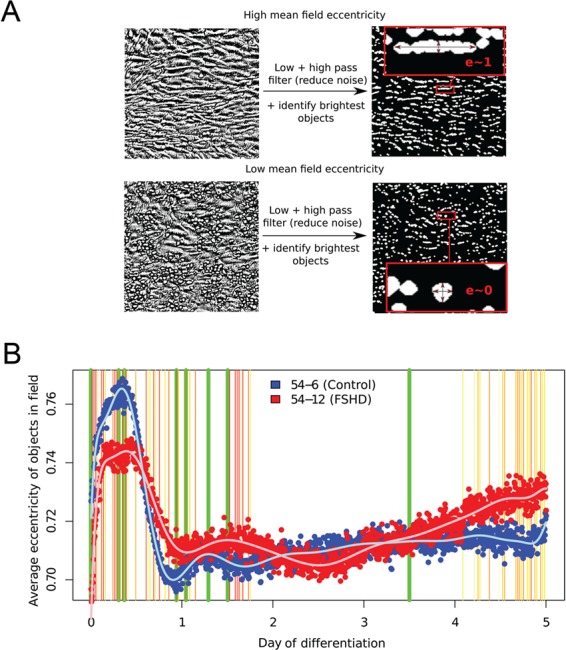
High-throughput time course imaging reveals morphological differences between myogenesis in FSHD and control myoblasts. (A) Schema showing how image analysis software processes and quantifies the eccentricity/elongation of cells in a phase contrast image of differentiating myoblasts. (B) FSHD 54-12 and matched control 54-6 myoblasts were plated in triplicate in 96 well plates and induced to differentiate over 5 days. Cells were imaged every 5 min over the differentiation process and the images processed by our software. Mean eccentricities for each cell line are plotted and a polynomial curve of best fit is shown. An empirical Bayes approach was employed to ascertain time points that showed significant differences in eccentricities control 54-6 and FSHD 54-12 cell lines. Thin vertical lines show time points that reached significance at the 5% level, and are coloured yellow to red in order of significance. Thick vertical green lines correspond to time points selected for investigation by RNA-sequencing. After day 3.5 (last vertical green line) myotubes began contracting and detaching from the plates.